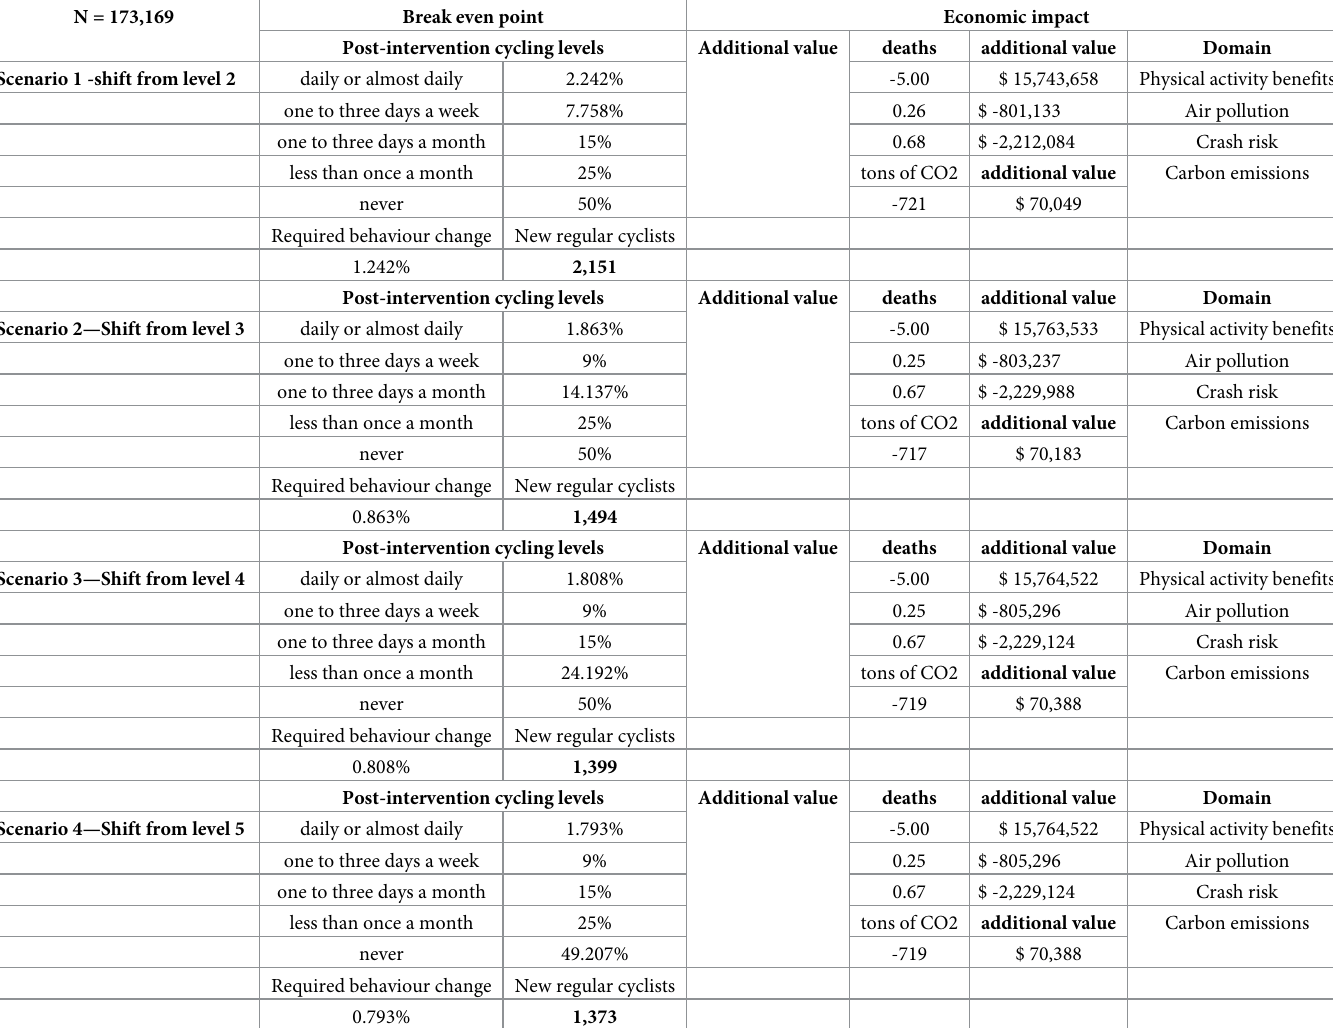
Table 2. Break even point estimates of increase in regular cyclists (level